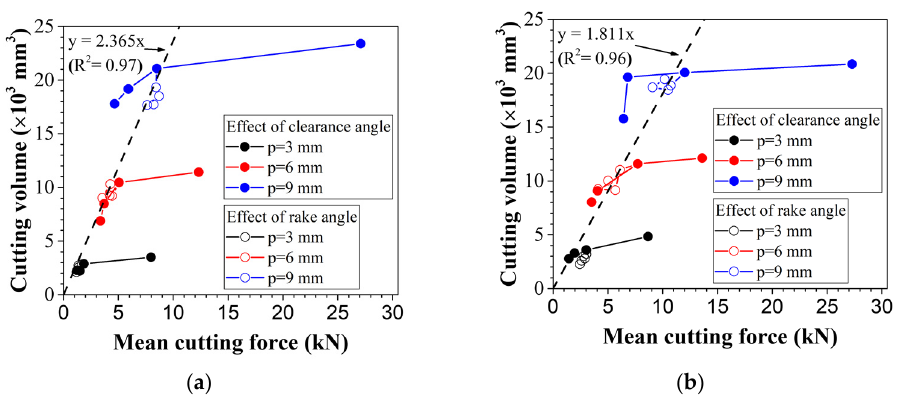
Figure 17. Relationship between the cutting volume and cutting force: ( a ) UCS 40 MPa rock; and ( b ) UCS 50 MPa rock.